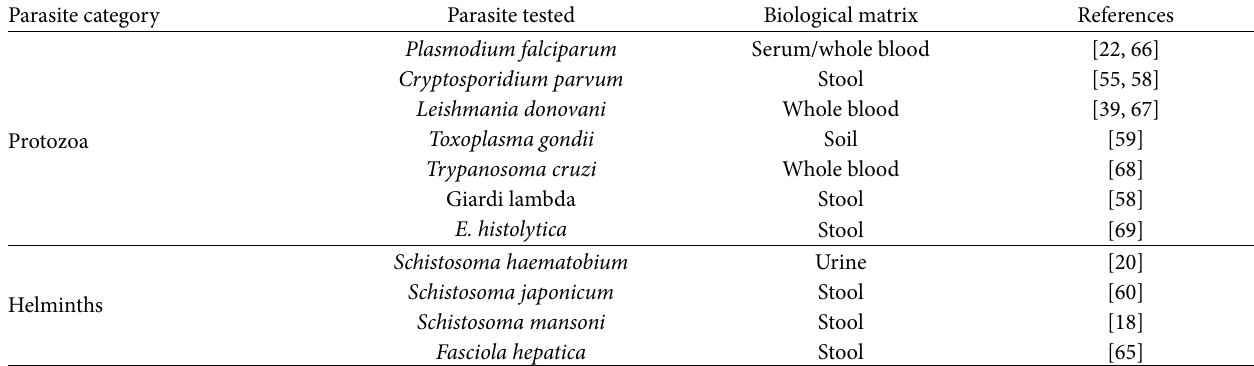
Table 4: Application of RPA in diagnosis of helminthic and protozoan infections in humans and animals.